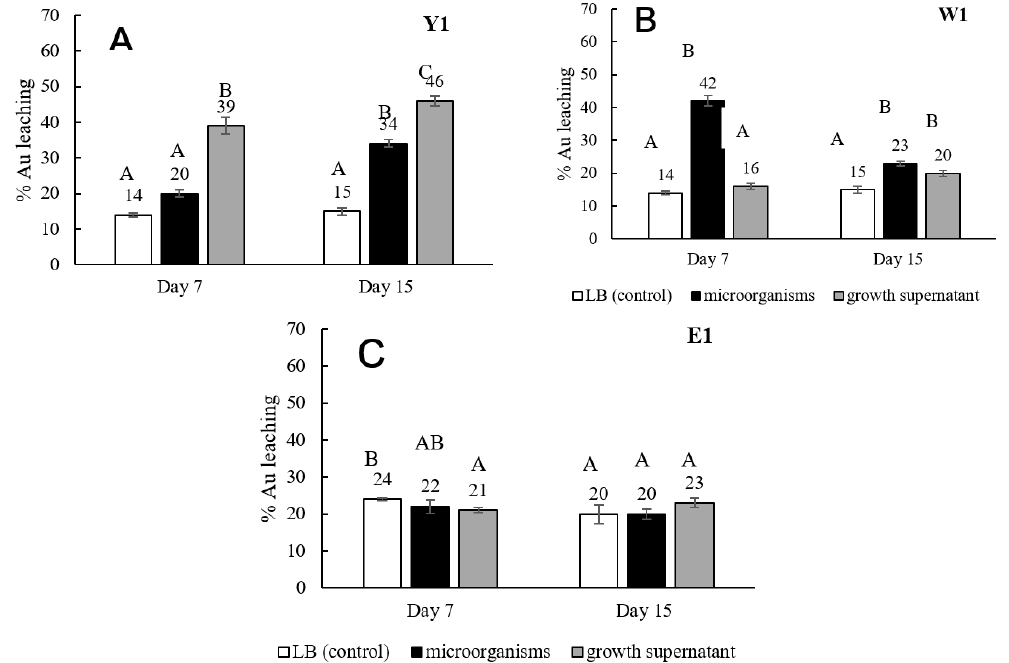
Figure 2. Bioleaching of gold from silicate ores by ( A ) Macrococcus caseolyticus (Y1), ( B ) Acinetobacter calcoaceticus (W1), and ( C ) Bacillus sp. MBEA40 (E1) under 7 days and 15 days. Various strains were cultured in Luria Bertani medium (LB) and shaken at 150 rpm, 30 °C (a particle size of ores approximately ≤ 75 µm). Data were expressed as the mean ± SD ( n = 3). Data were analyzed by Duncan’s test ( p < 0.005). The capital letters compared the percentage of gold bioleaching by three isolated strains (A—Y1, B—W1, and C—E1) under control, in the present of microorganism and growth